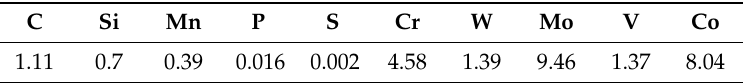
Table 1. Chemical compositions of AISI M42 high-speed steel. (wt.